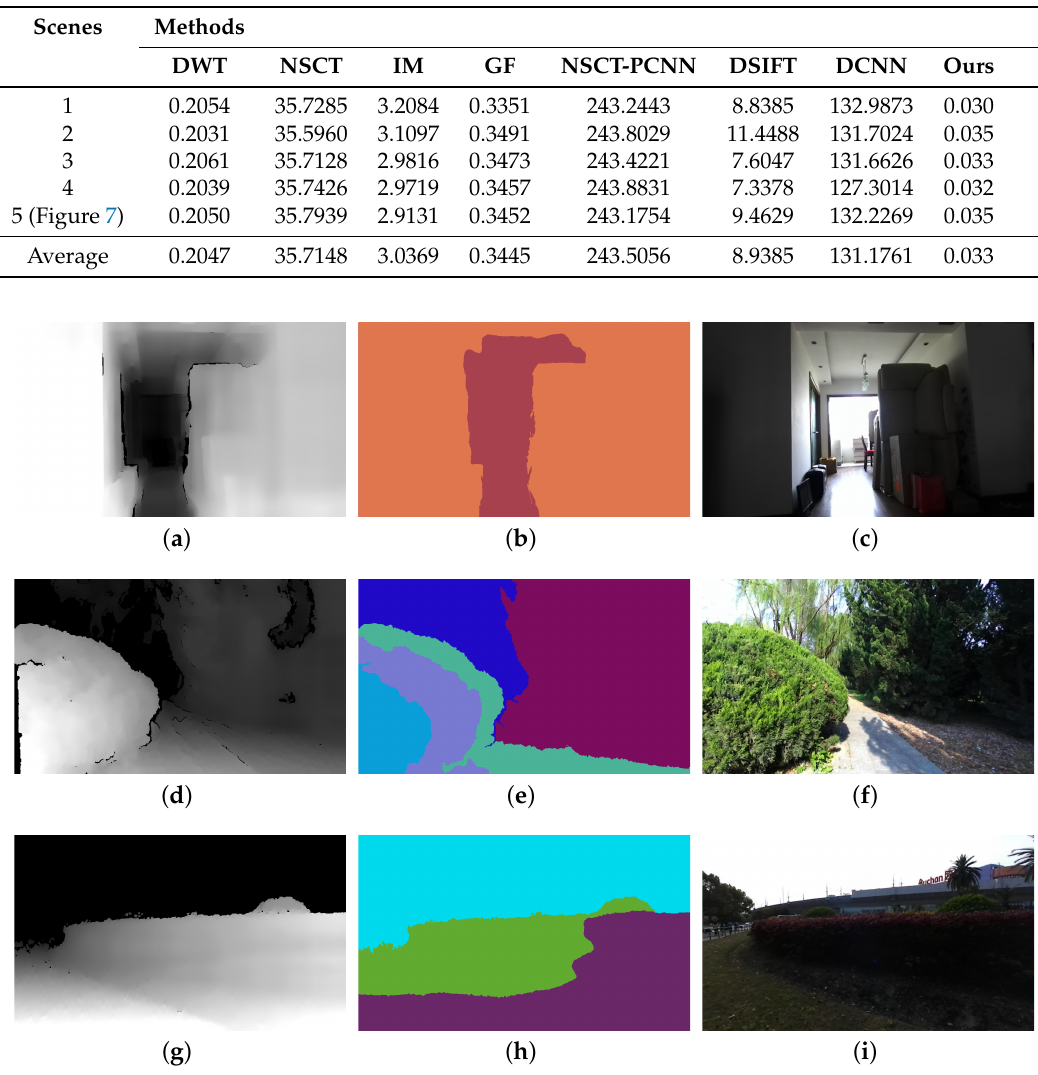
Table 5. Running time (seconds) of the proposed method and existing multi-focus image fusion algorithms for the five test scenes.